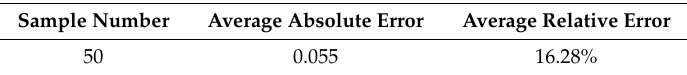
Figure 12. Comparison between inversion AOD and MOD 04 AOD. The black dots represent 50 sets geographical location, and the red solid line represents y = x. Table 7. Validation of inversion AOD and MOD_04 AOD.